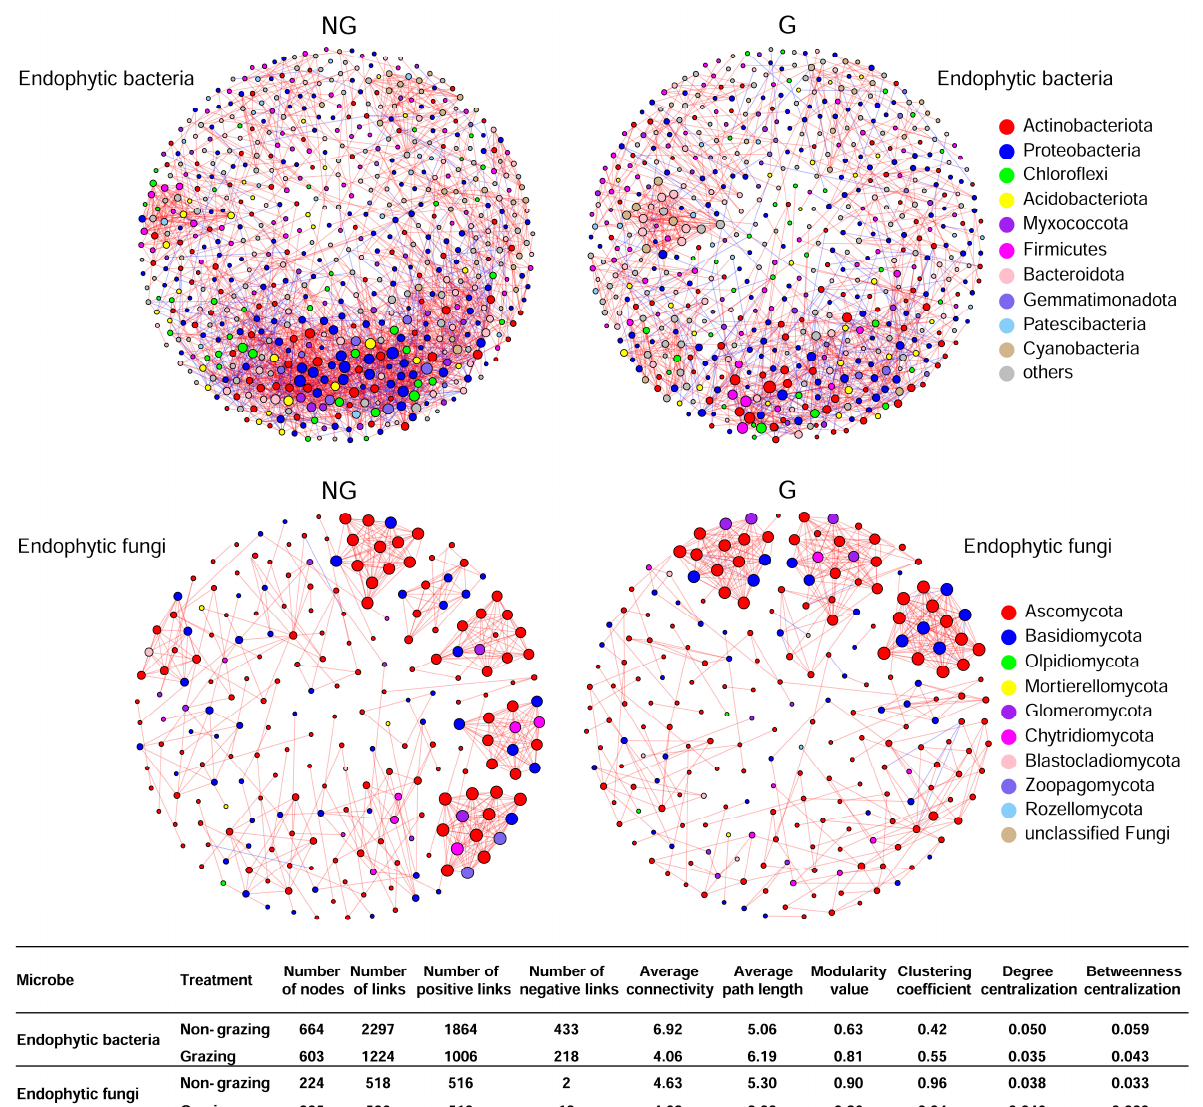
Figure 6. Network analysis showing the interactions in endophytic bacterial and fungal communities of Leymus chinensis grown non-grazed and grazed grasslands at the phylum level. Red lines represent significant positive interactions (Spearman’s correlation, p < 0.05) between nodes, while blue links represent negative interactions (Spearman’s correlation, p < 0.05). NG: non-grazed grassland; G: grazed